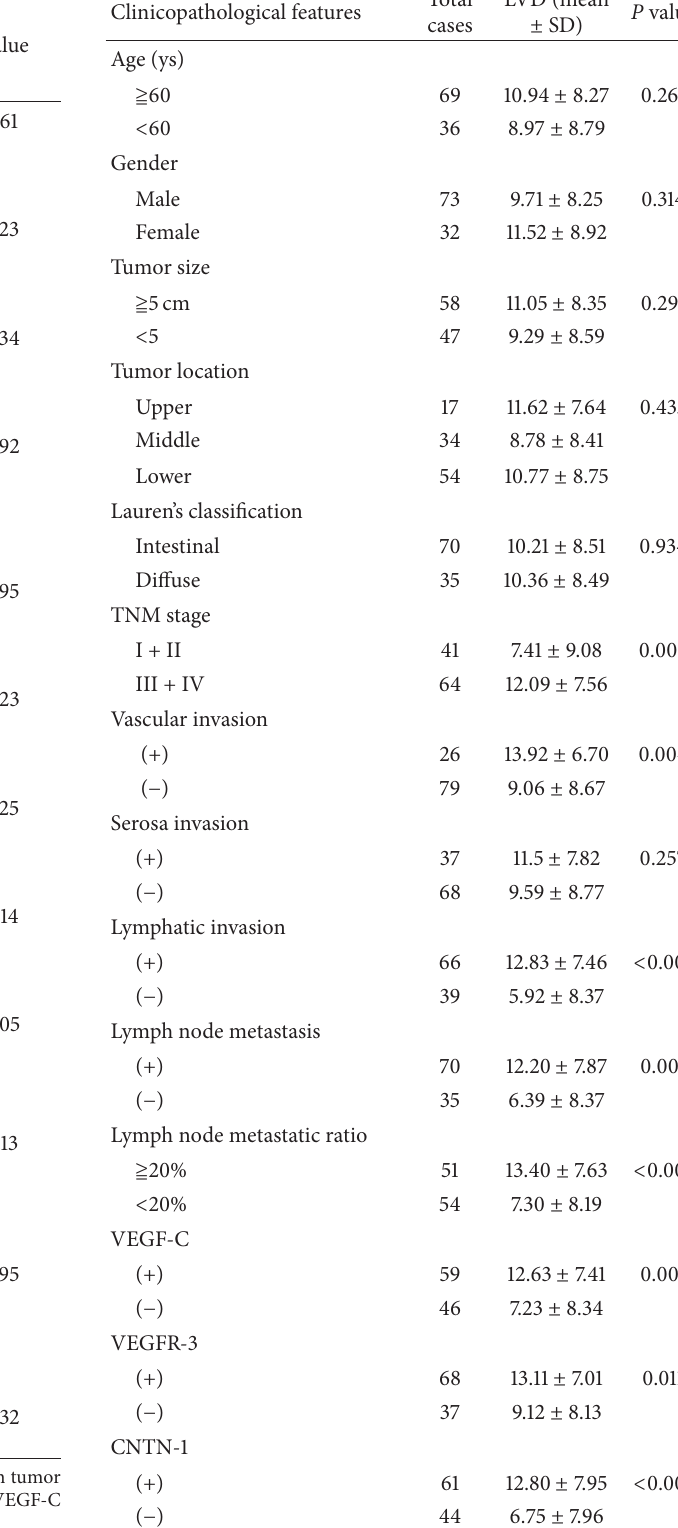
Table4:CombinedexpressionsofVEGF-CandCNTN-1associated with clinicopathologic characteristics ( 𝑛 /%).